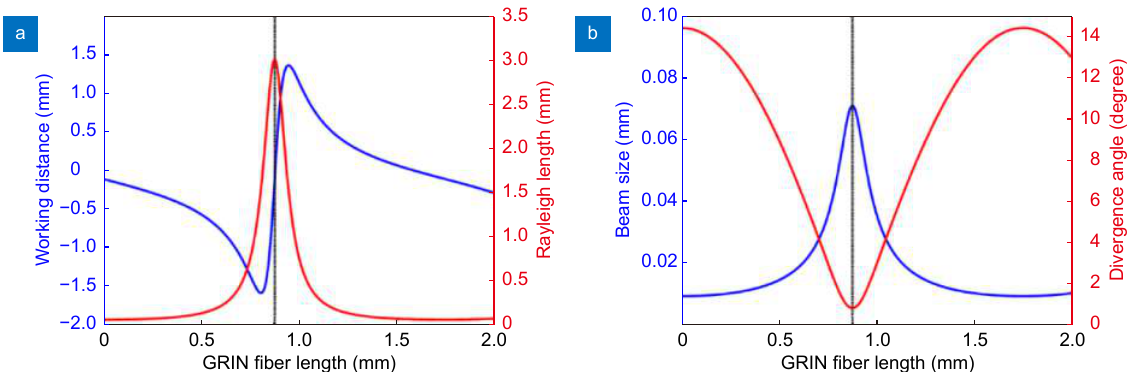
Fig. 3 | ( a ) Working distance and Rayleigh length versus different GRIN fiber length. ( b ) Beam size and divergence angle versus different GRIN fiber length.